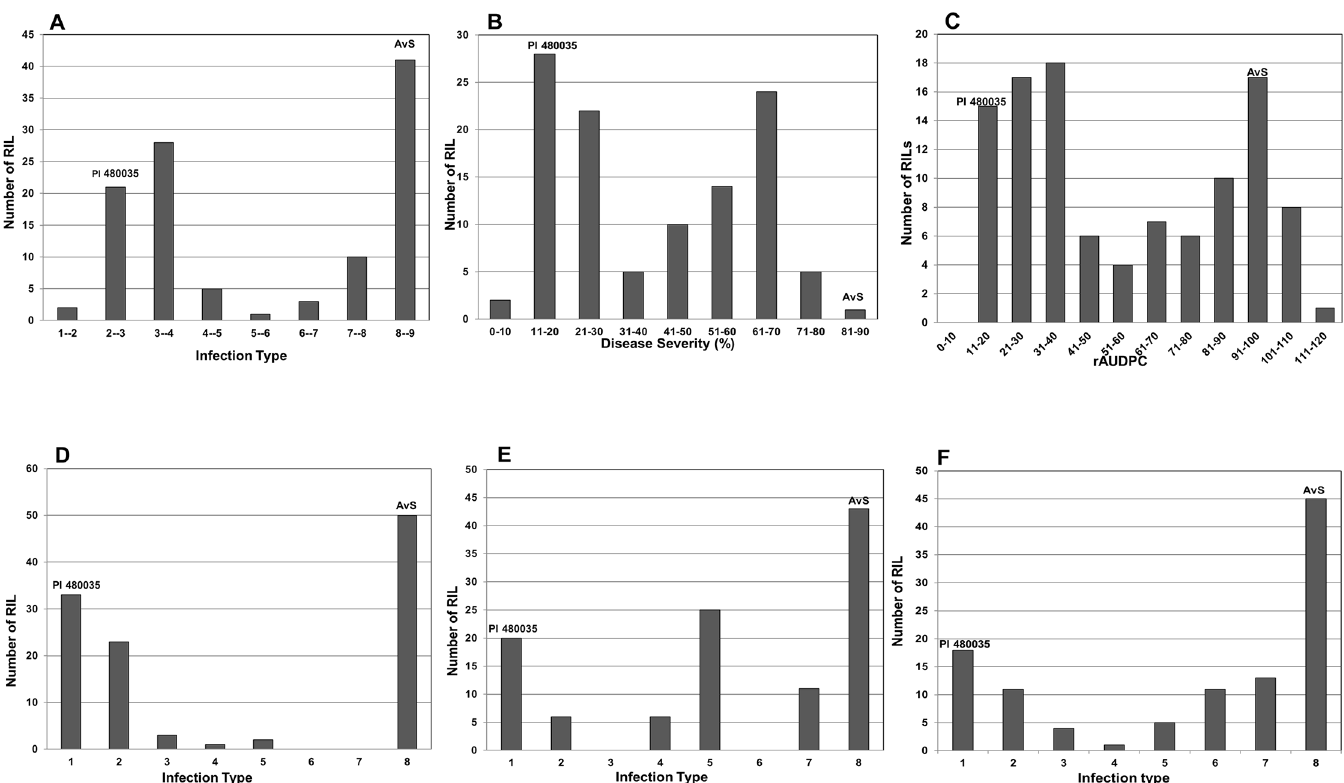
Fig 1. Histograms for the AvS × PI 480035population for the distribution of seedling infection types (IT) for three Puccinia striiformis f. sp. tritici racesand mean values of IT, disease severity (DS), and relative area under disease progress curve (rAUDPC) across all seasons and environments (Pullman 2013, Pullman 2014, and Mt. Vernon 2014). (A) Mean IT; (B) Mean DS; (C) Mean rAUDPC; (D) IT for race PSTv-14; (E) IT for race PSTv-37; and (F) IT for race